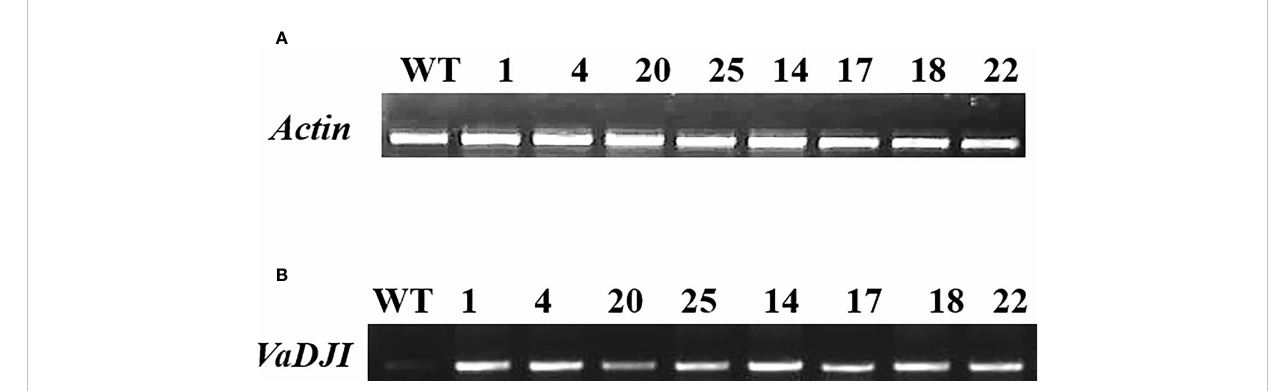
FIGURE 2 Semi-Quantitative real-time analysis of VaDJI T 2 transgenic lines using speci fi c primers for VaDJI gene and actin (as an internal reference). (A, B) - Lane1: represents cDNA from wild type (WT). Lane 2-9: represents cDNA from transformants. Depending on the level of expression, lines L-20, L-25 and L-17 were considered low expression lines. Lines L-1, L-4, L-14 and L-18 were considered high expression lines.